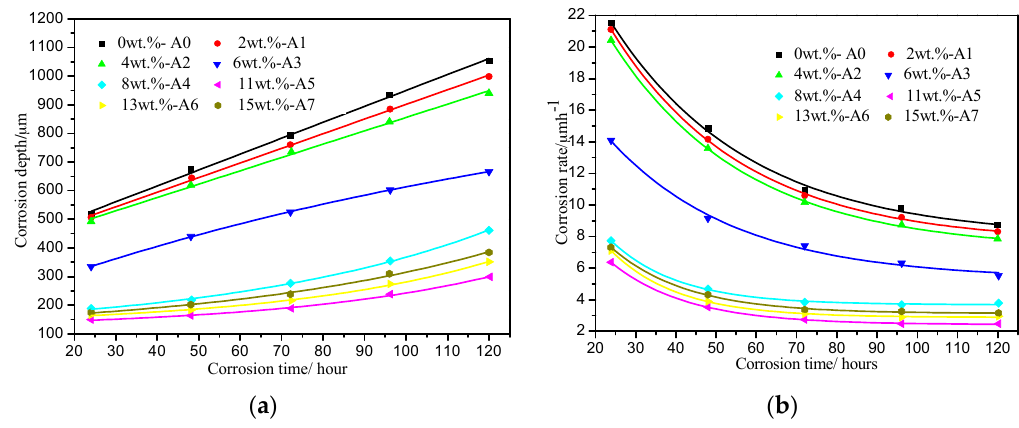
Figure 4. The relationships of corrosion depth ( a ) and corrosion rate ( b ) with corrosion time.